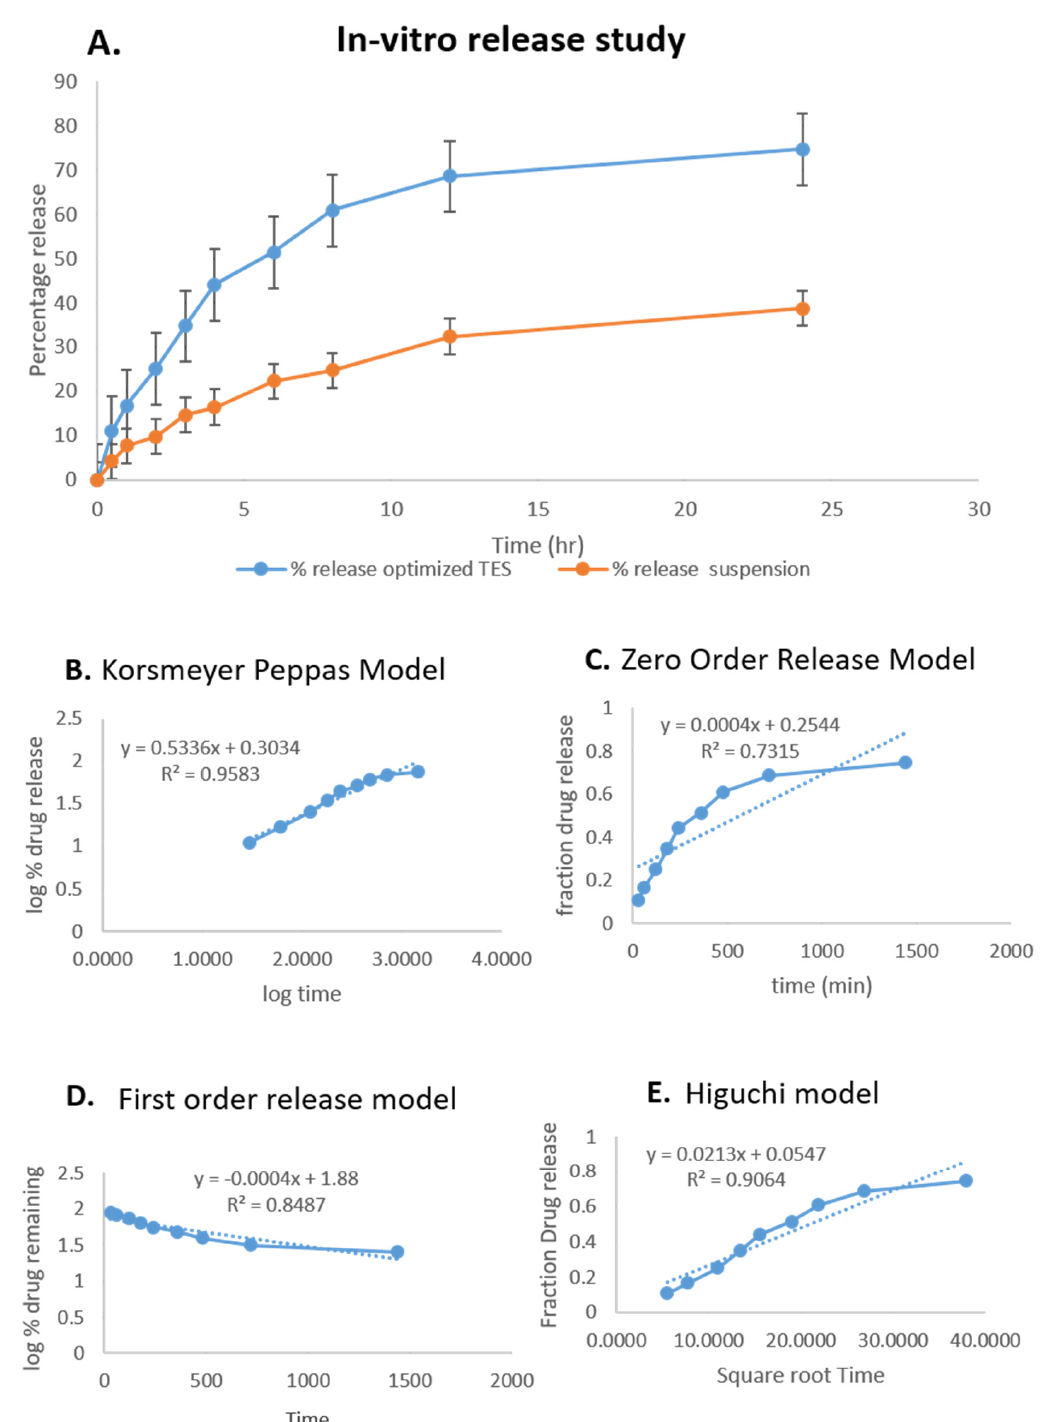
Figure 5. ( A ) Comparative in vitro release profiles and in vitro release kinetics graphs of HTC-TES at pH 7.4. ( B ) Korsmeyer–Peppas model. ( C ) first-order model. ( D ) zero-order model. ( E ) Higuchi model.